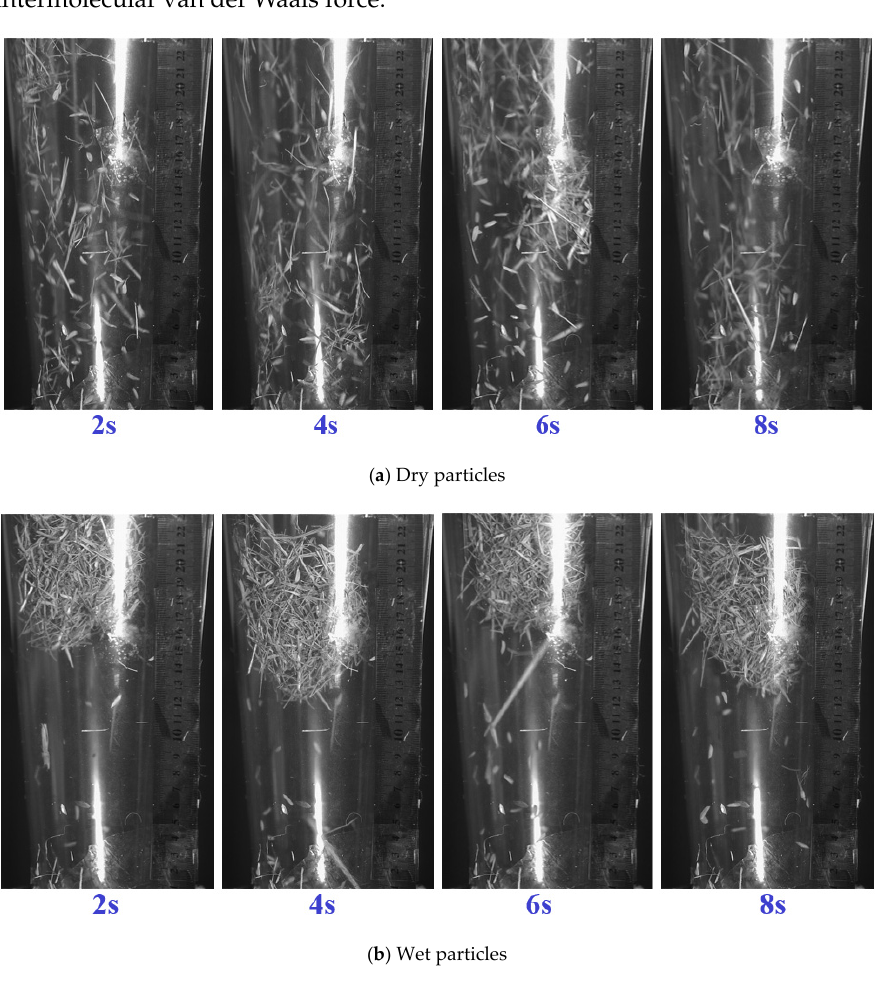
Figure 6. Flow state of rice threshed mixture ( v = 7.60 m/s and t = 8 s).